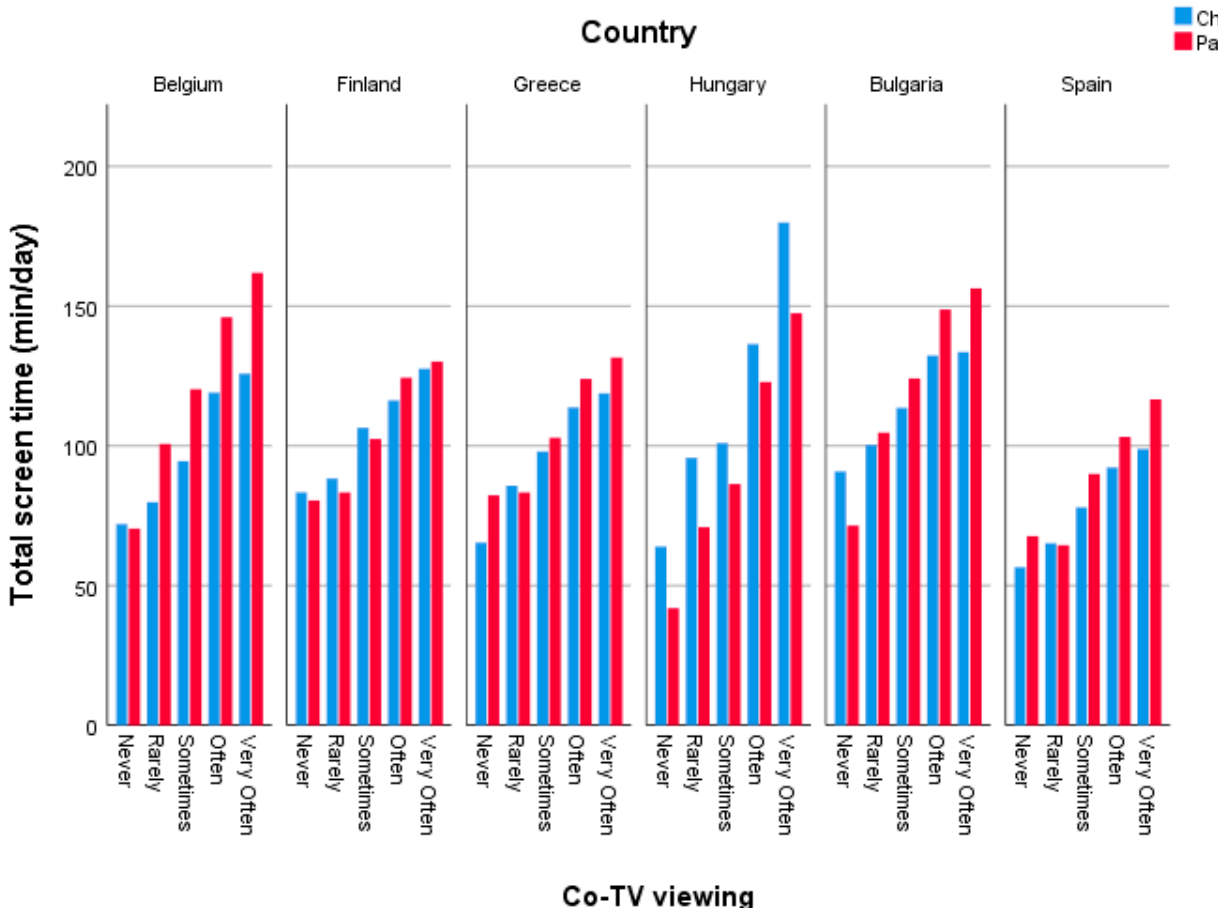
Figure 5. Graphical representation of the association between co-TV viewing and children’s (in blue) and parents’ (in red) screen time (min/day) for the six European countries.